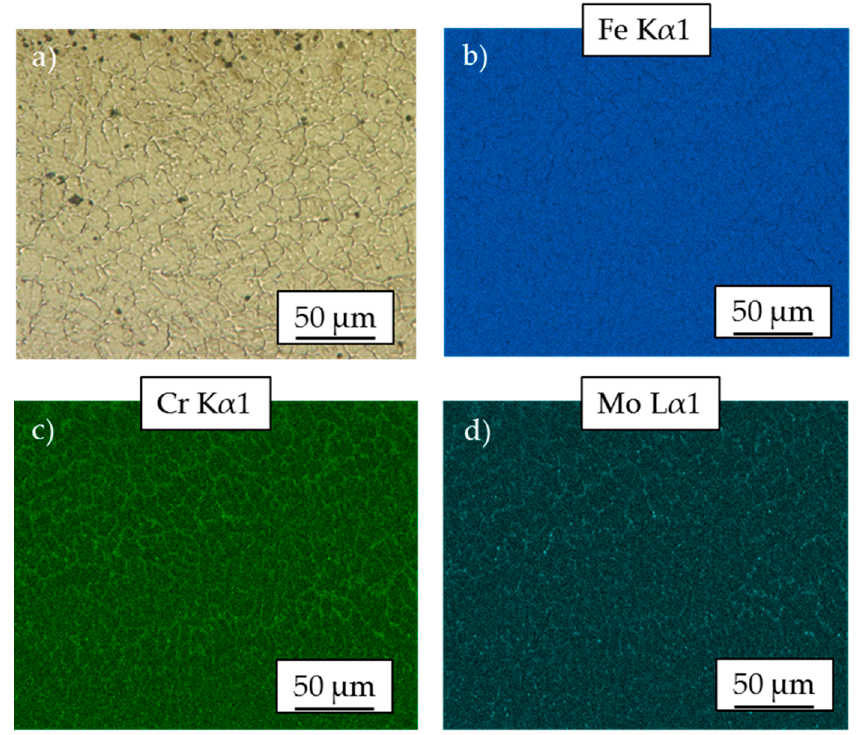
Figure 12. ( a ) Microscope image of etched cross-section (V2A etchant) and EDX-mapping/element distribution of ( b ) Fe, ( c ) Cr and ( d ) Mo (processing parameters: P = 800 W, (cid:1865)(cid:4662) = 3.7 g/(cid:1865)(cid:1861)(cid:1866) , f rate = 400 mm/min) .